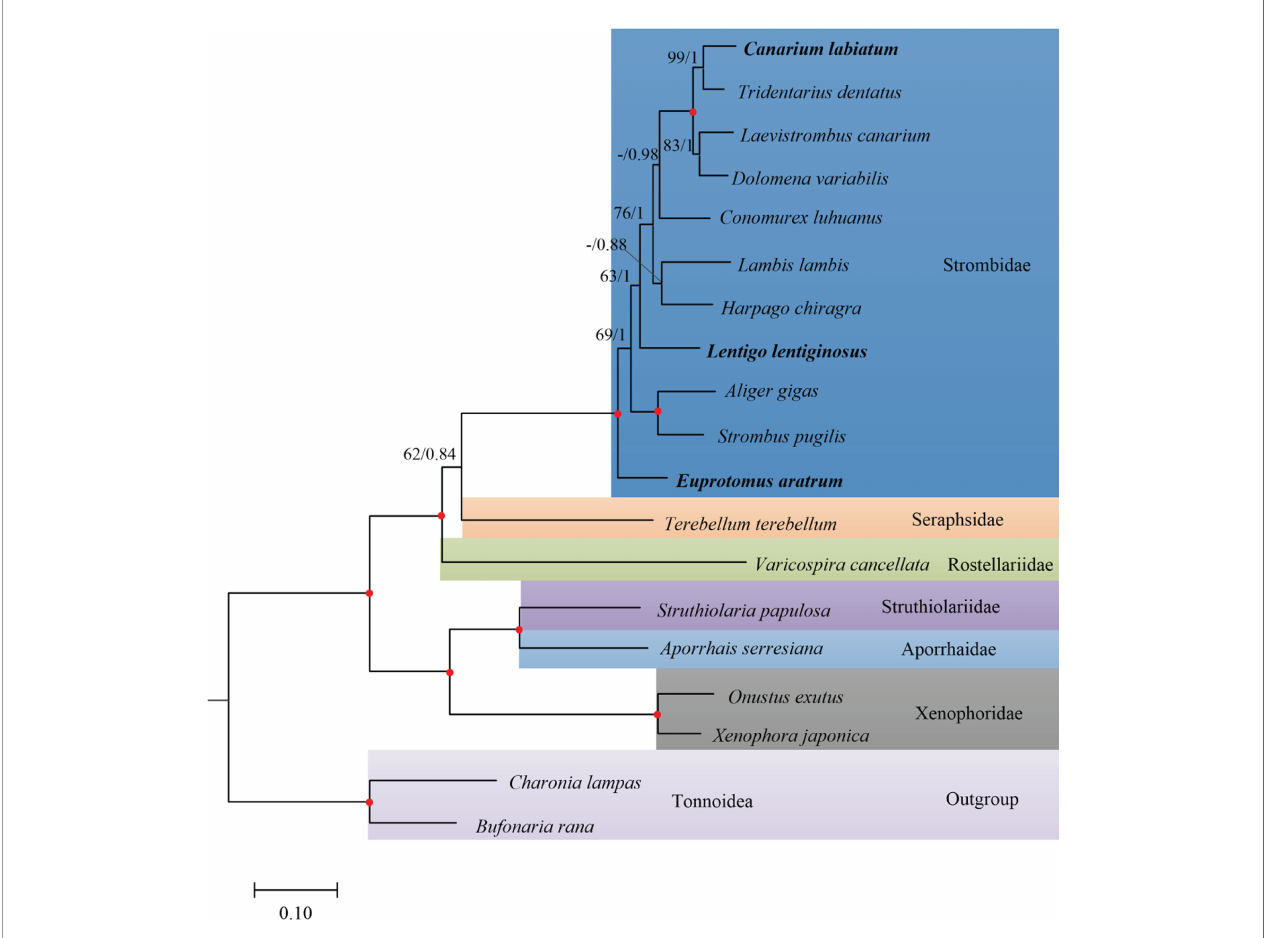
FIGURE 4 | Phylogenetic relationship of Stromboidea based on the combined amino acid sequences of 13 mitochondrial protein-coding genes (PCGs) plus nucleotide sequences of 2 ribosomal RNA (rRNA) genes: the reconstructed maximum likelihood (ML) phylogram using Charonia lampas and Bufonaria rana as outgroup is shown. The fi rst number at each node is bootstrap proportion (BP) of maximum likelihood (ML) analyses, and the second number is Bayesian posterior probability (PP). Nodal with maximum statistical support (BP = 100; PP = 1) is marked with a solid red circle. BP values of ML under 60 are not shown in the